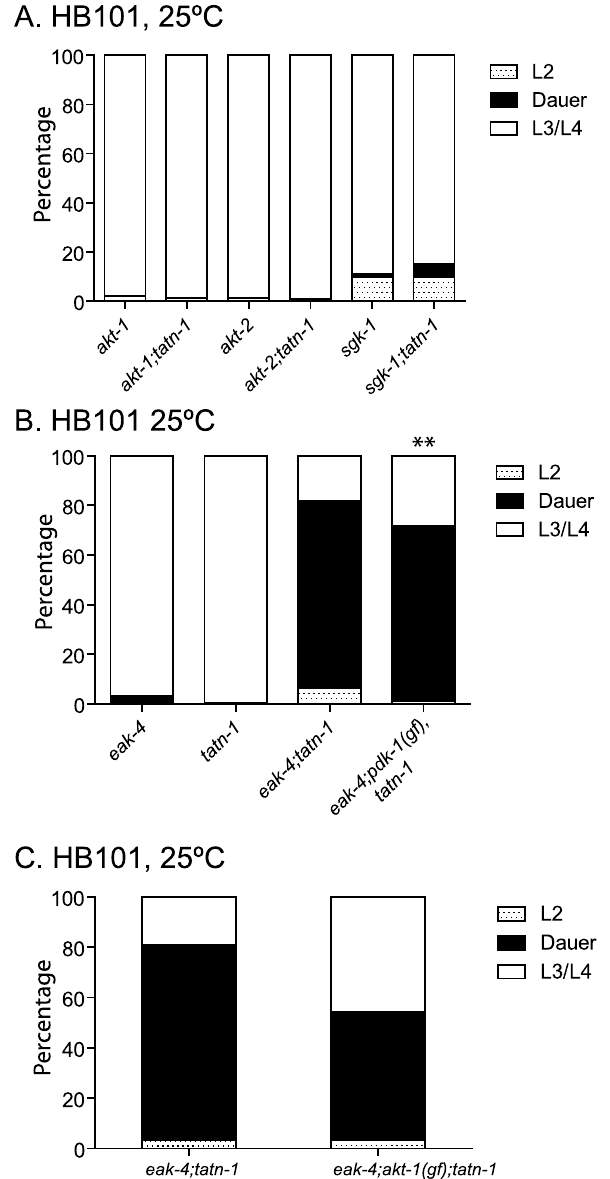
Figure 4. tatn-1 effects on development do not require changes in PI3 kinase signaling. (A) tatn-1(baf1) does not augment dauer arrest by mutants with loss-of-function mutations in the protein kinase B genes akt-1 , akt-2 , or sgk-1 . (B) The pdk-1(mg142) gain-of-function allele minimally affects dauer formation by eak-4(mg348); tatn-1(baf1) mutants. % dauers observed was 75.6% in eak-4; tatn-1 and 70.7% in eak-4; pdk-1(mg142); tatn-1 . ** p , 0.001 by Fisher’s exact test. (C) The akt-1(mg144) gain-of-function allele weakly inhibited dauer formation by eak-4(mg348); tatn-1(baf1) mutants. % dauers observed was 77.6% in eak-4; tatn-1 and 51% in eak-4; akt-1(mg144); tatn-1